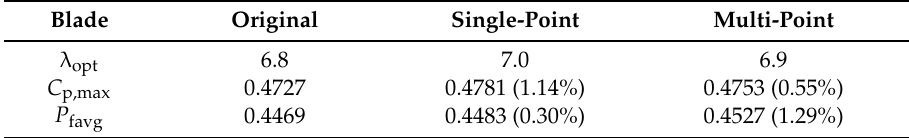
Table 5. Comparison of static aerodynamic performance and closed-loop performance.